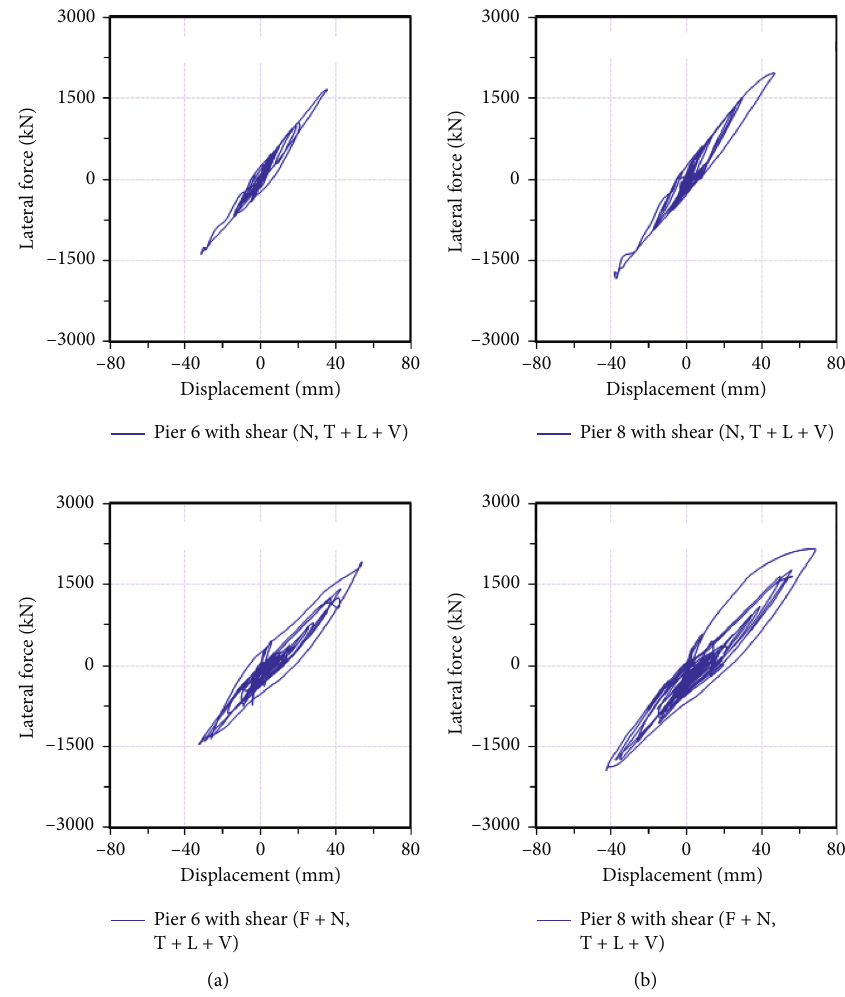
Figure 10: Transverse hysteretic response of the flexure-shear-axial interaction model subjected to triaxial input ground motions of N and F+N earthquakes. (a) Pier 6. (b) Pier